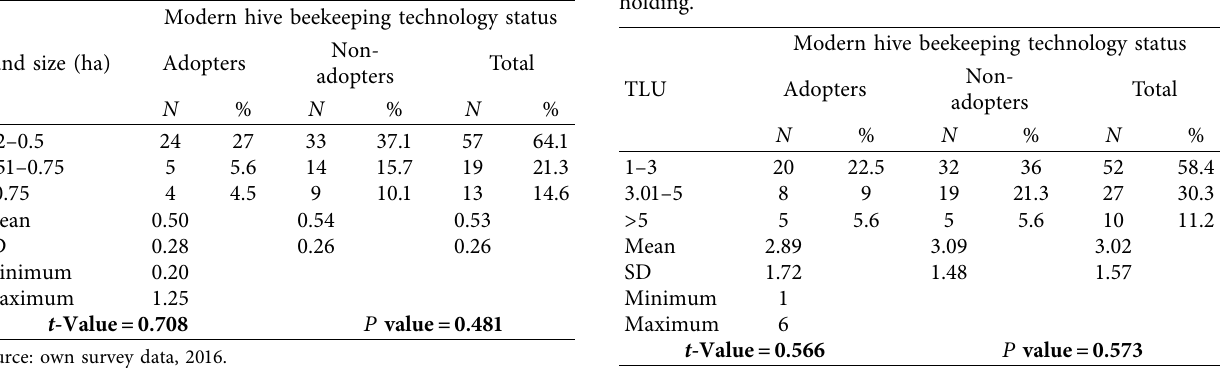
Table 8: Distribution of household respondents by livestock holding.